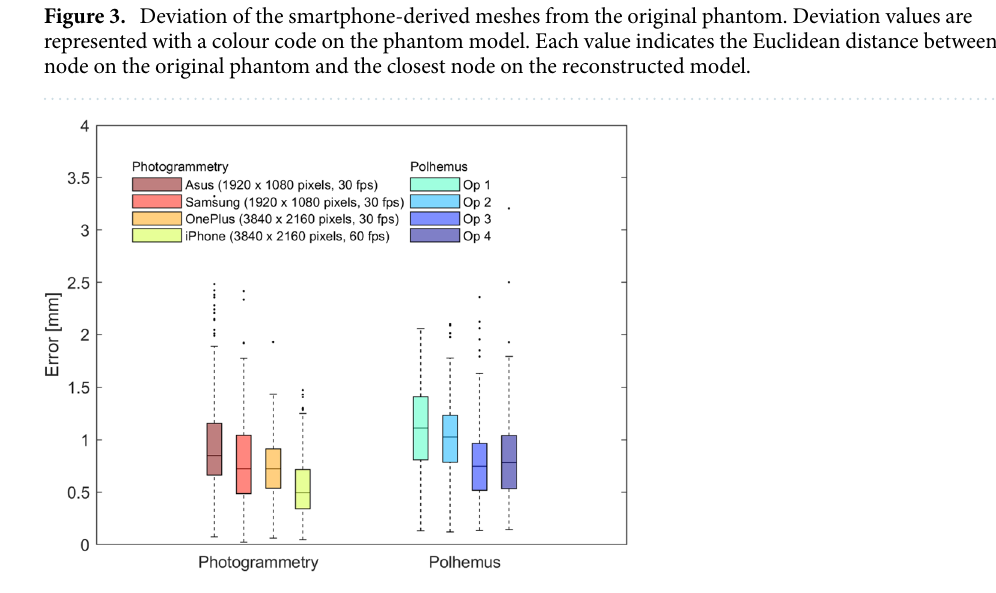
Figure 4. Localization errors for the sensor positions obtained with photogrammetry and Polhemus for the head phantom. Boxplots represent the distribution of the errors across sensor positions, separately for each employed smartphone for the photogrammetry-based method (on the left) and for each operator for the Polhemus (on the right). Bottom and top edges of the box indicate the 25th and 75th percentile, whereas the central mark indicates the median. Outliers are depicted as